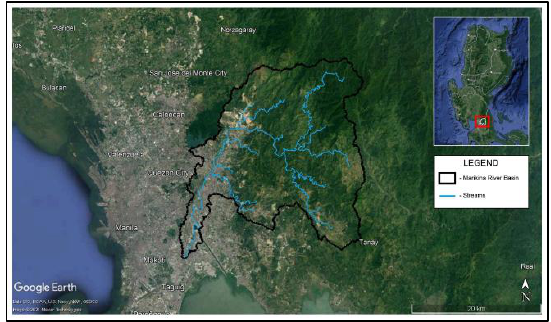
Figure 1. Study site location in Google Earth.